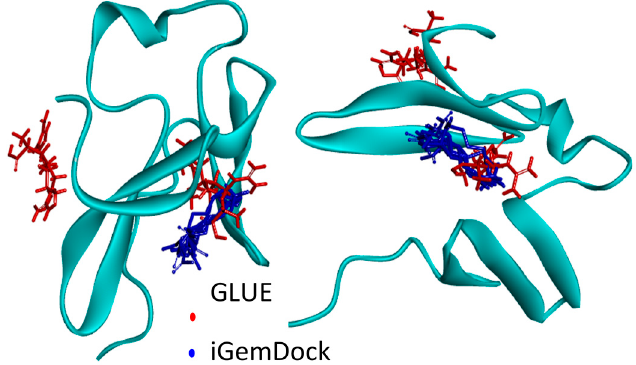
Figure 1. Frontal and side view of the molecular docking solutions of WW34 (green) interactions with arginine obtained with GLUE ( red ) and iGemDock ( blue ).